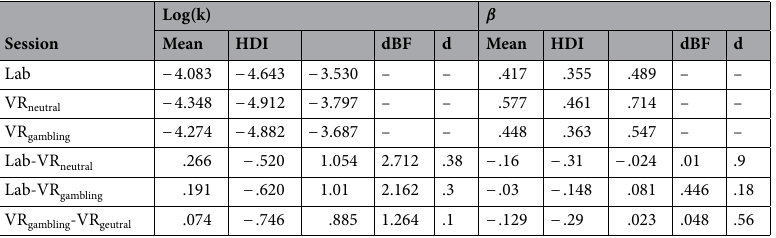
Table 2.. 95% HDIs for the two parameters of the hyperbolic discounting model. HDIs are described by the min. value first and the max value second. Directional Bayes Factors (dBF) are calculated as BF = i/(1-i), with i being the probability mass of the difference distributions above zero. Effect sizes are given as Cohen’s